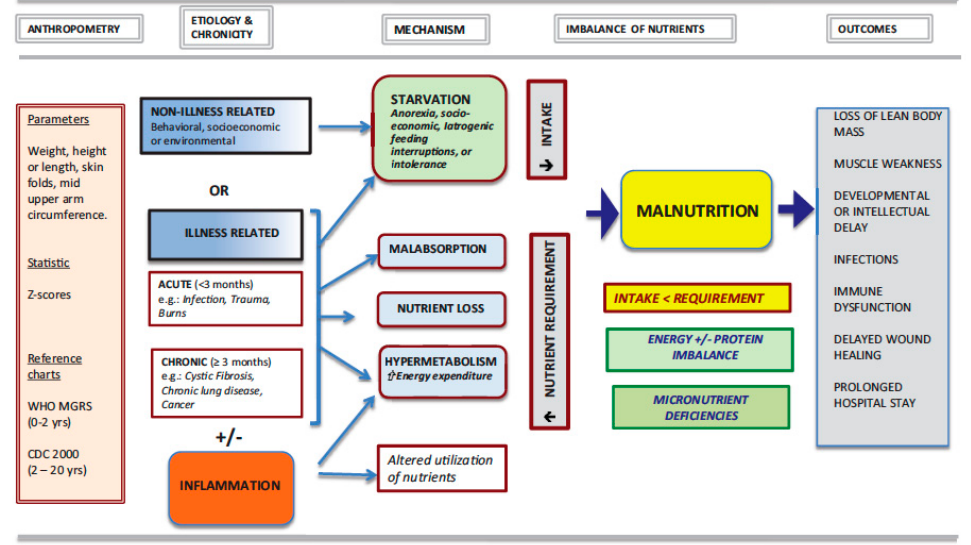
Figure 1. The key concepts in establishing malnutrition in hospitalized children. Reproduced with permission from Mehta NM, et al [31]. Journal of parenteral and enteral nutrition . 2013, 37, 460-481.